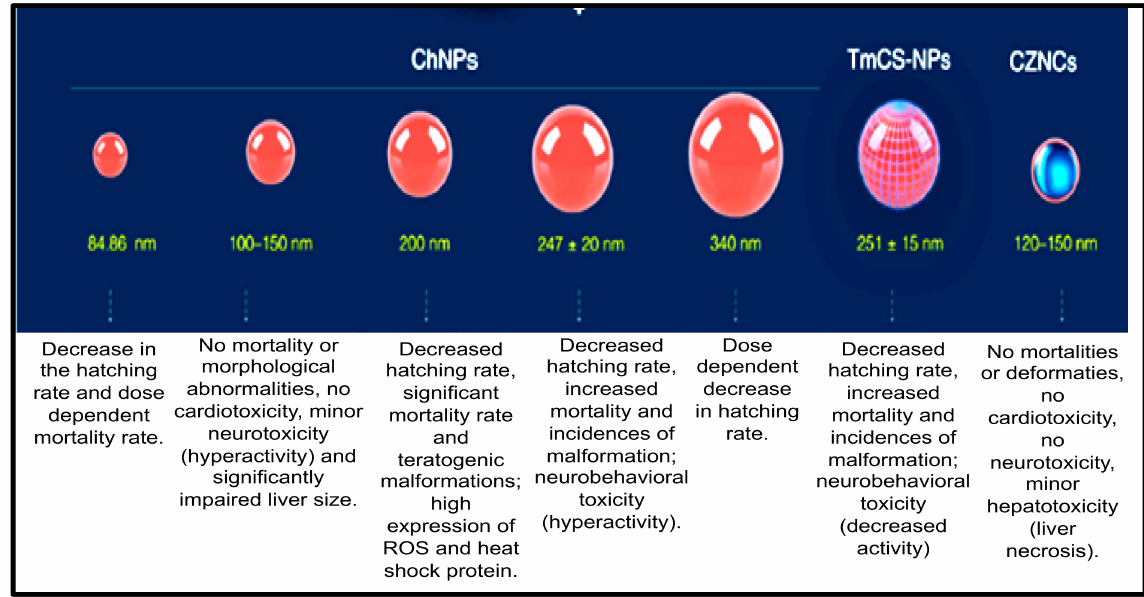
Figure 5. Toxicity evaluation of the different sizes of chitosan-based nanomaterials: summary of the results obtained